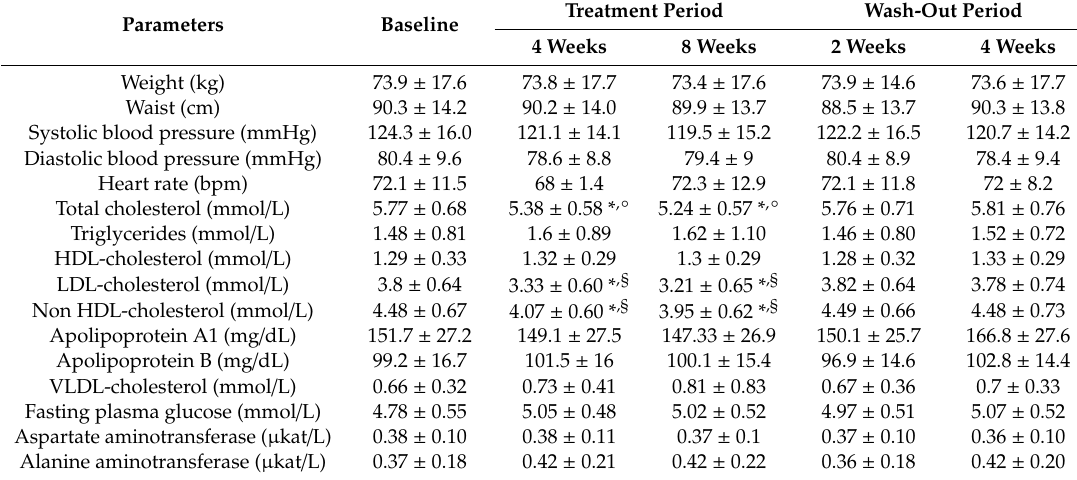
Table 5. Changes in anthropometric, hemodynamic, and blood chemistry parameters from the baseline / end of washout to the end of the supplementation with beta-glucan, expressed as mean ±